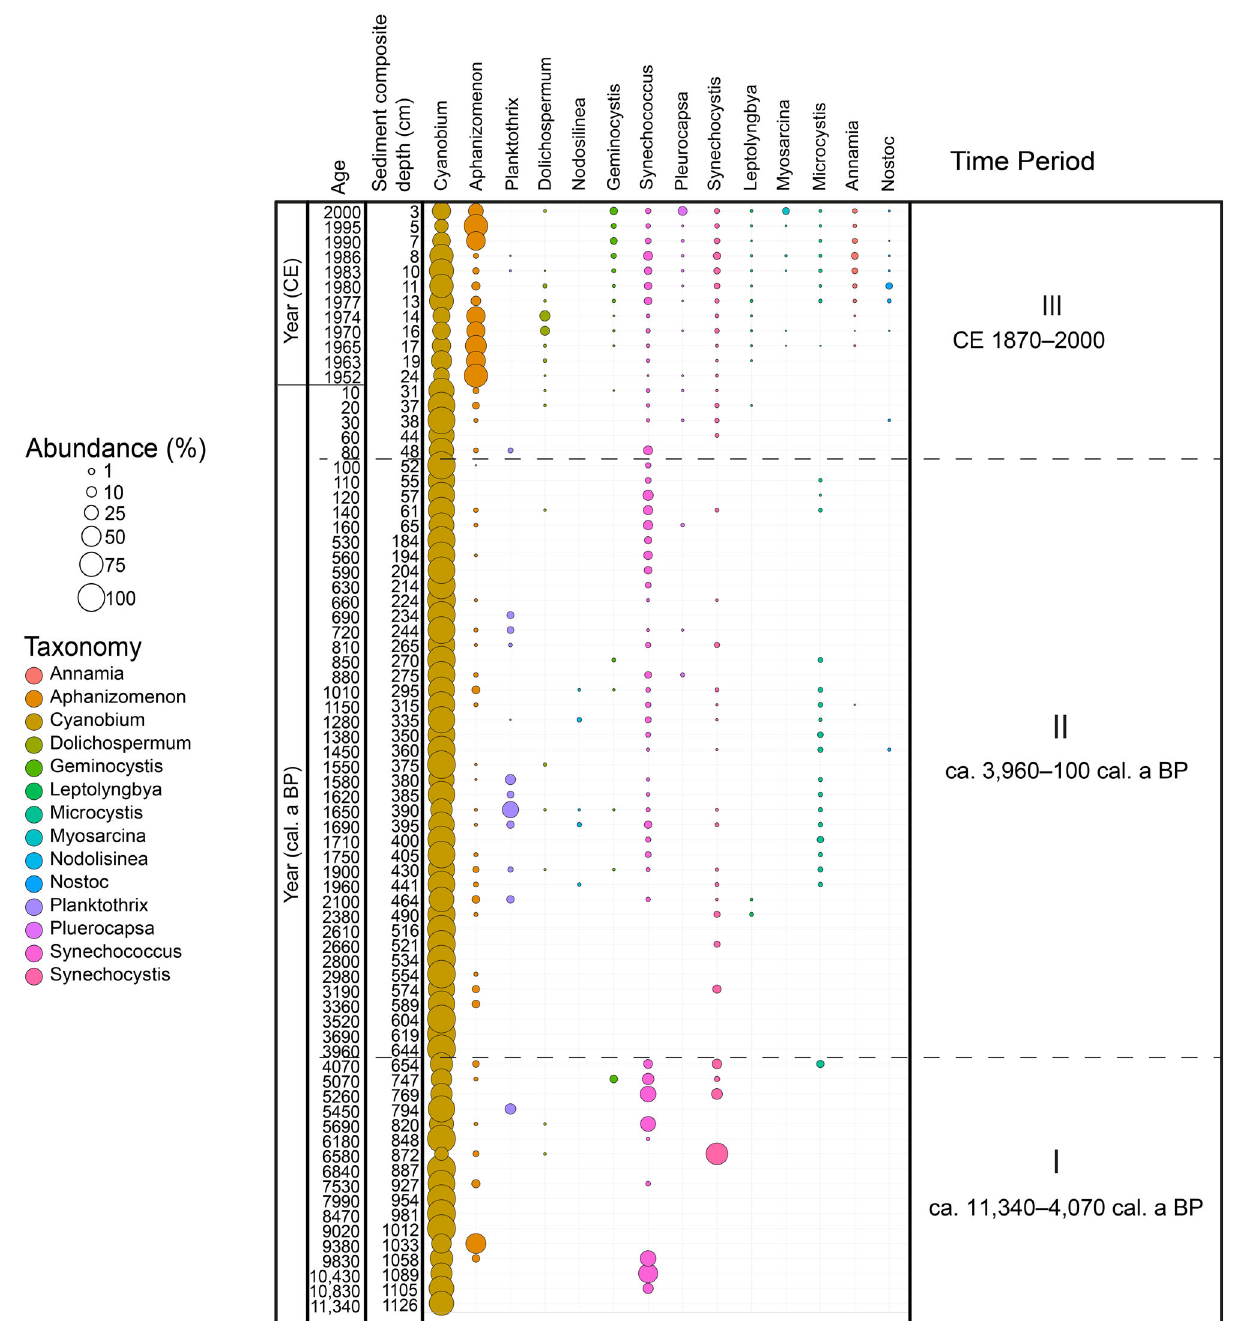
Fig. 3 Cyanobacteria taxonomic distribution. Bubble plot showing the variation of cyanobacteria community composition at the genus level (cutoff >0.1% relative abundance, the tiny dots represent ~0.1% abundance) spanning over 11,000 years. Dashed black lines demarcate the three signi fi cantly different temporal clusters identi fi ed by non-metric multidimensional scaling (see Fig.